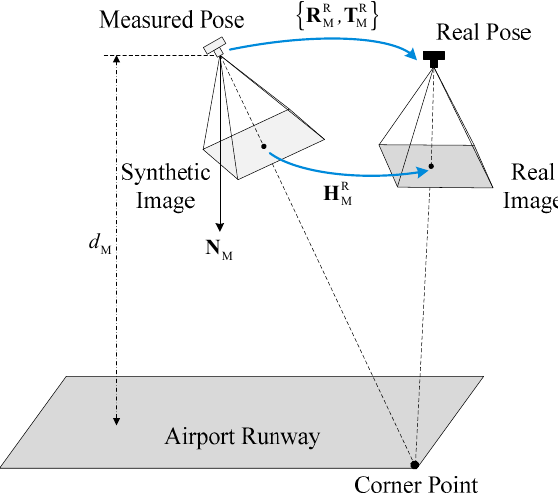
Figure 3. Homography between synthetic and real images